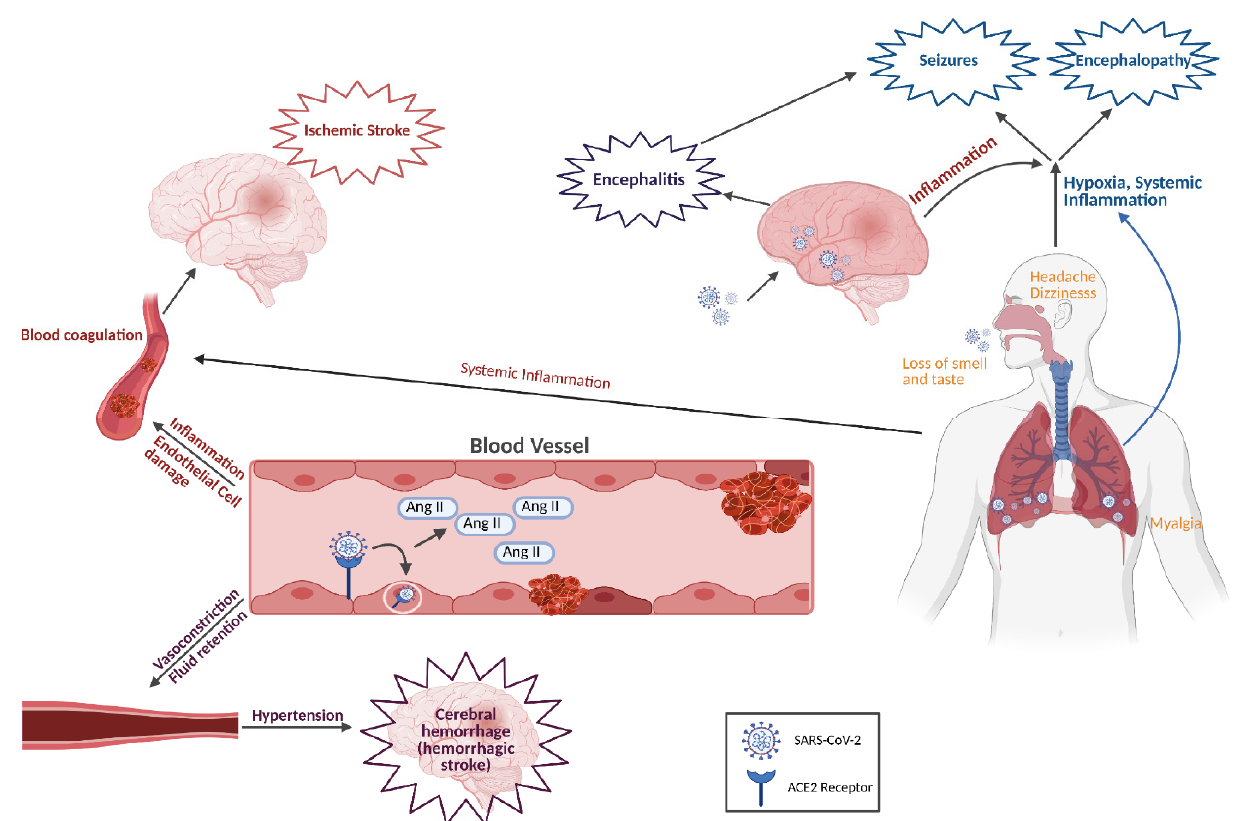
Figure 2. Mechanisms of COVID-19 neurological complications. Lung infection by SARS-CoV-2 results in severe inflam- mation, acute respiratory distress syndrome (ARDS), and hypoxia. This leads to hypoxia- and inflammation-induced encephalopathy and seizures. Brain damage due to viral replication may lead to encephalitis. Severe systemic inflammation could result in hypercoagulability which may eventually lead to stroke. Nonspecific symptoms due to nervous system affections include headache, dizziness, loss of taste and smell, and myalgia. Usage of ACE2 receptor; by SARS-CoV-2, to infect target cells, including endothelial cells, would deplete the receptor resulting in the accumulation of angiotensin II (AngII). High levels of AngII promote vasoconstriction, fluid retention, inflammation, and blood coagulation, which could result in ischemic or hemorrhagic stroke. This figure was created with BioRender.com.